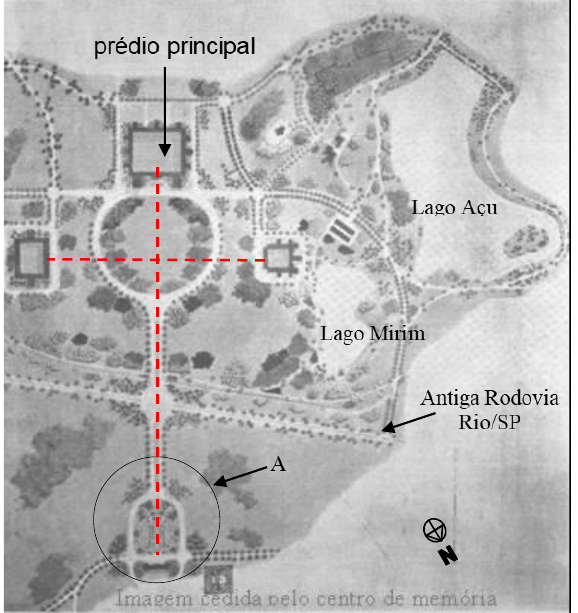
Figure 03 . Masterplan of the landscaping proposed by Reynaldo Dierberger, highlighting the axis between the main buildings cut by the Old Estrada Rio / SP Source: Memory Center of